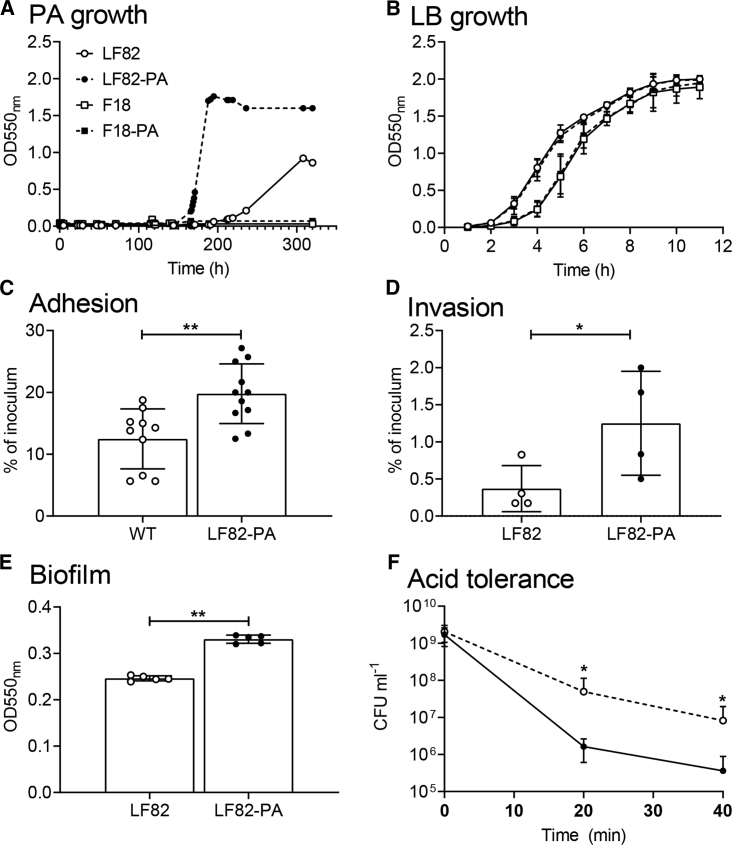
LF82 Utilizes PA as a Sole Carbon Source for Growth, and Exposure to PA Increases Virulence(A) LF82 and commensal E. coli strain F-18 were grown in minimal media supplemented with 20 mM PA over a series of five successive re-cultures. Growth rate of the PA-exposed strains, termed LF82-PA and F-18-PA, were subsequently compared to WT controls.(B) The growth rates of LF82, F-18, LF82-PA, and F-18-PA were unchanged in rich LB broth.(C and D) The ability of LF82 and LF82-PA strains to adhere to (C) and invade (D) Caco-2 intestinal epithelial cells was determined. Biofilm formation over 7 days of anaerobic growth was assessed in the presence of 20 mM PA (D).(E) The ability of LF82 and LF82-PA to tolerate acidic pH (pH 3) over time was determined by colony counts (E).Results displayed are the average of at least three independent biological replicates ± SD. Samples were analyzed using an unpaired t test where ∗p < 0.05 and ∗∗p < 0.01 (C–F).